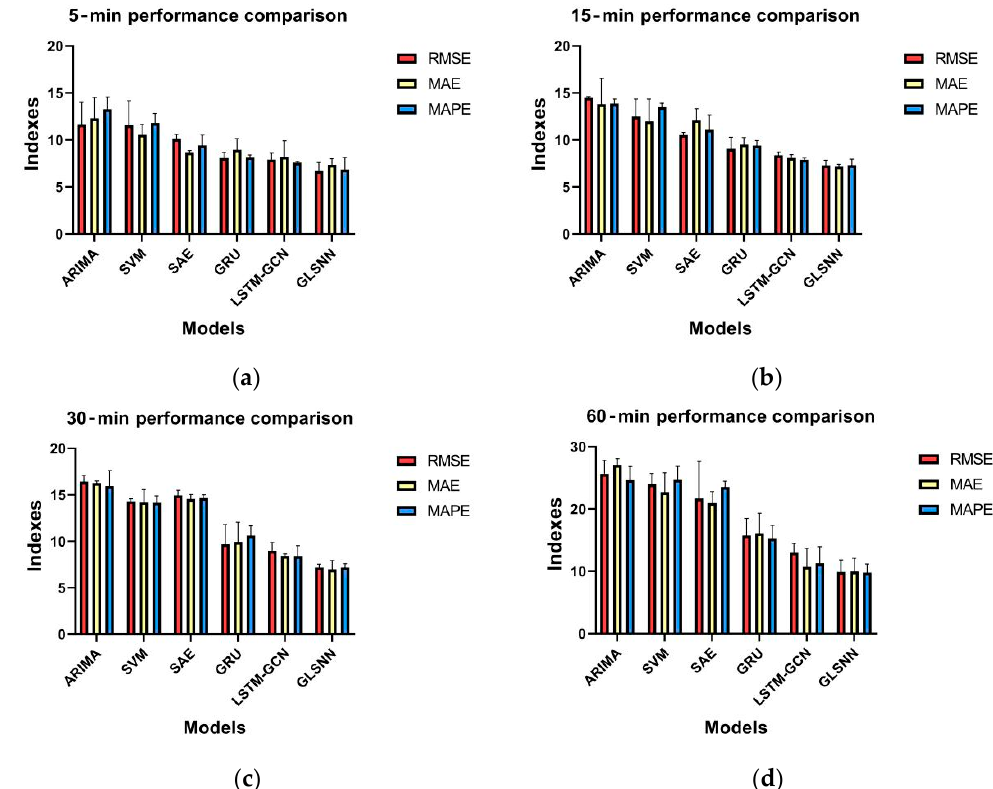
Figure 5. Comparison of model performance with prediction horizons of ( a ) 5, ( b ) 15, ( c ) 30, and ( d ) 60 min.